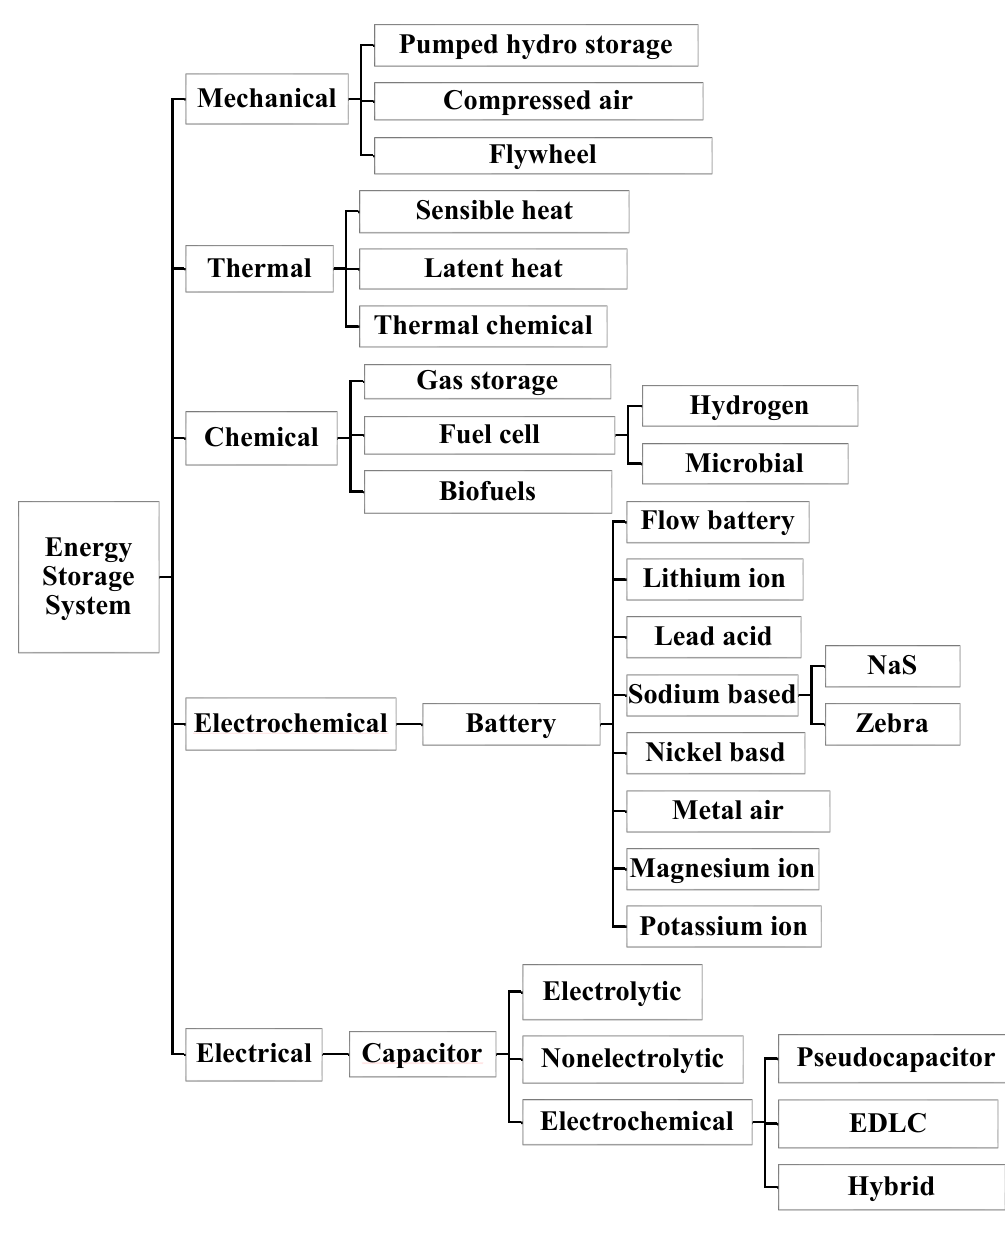
Figure 1. Classi fi cation of energy storage system (ESS) [8,9,13,14]. Figure 1. Classification of energy storage system (ESS)